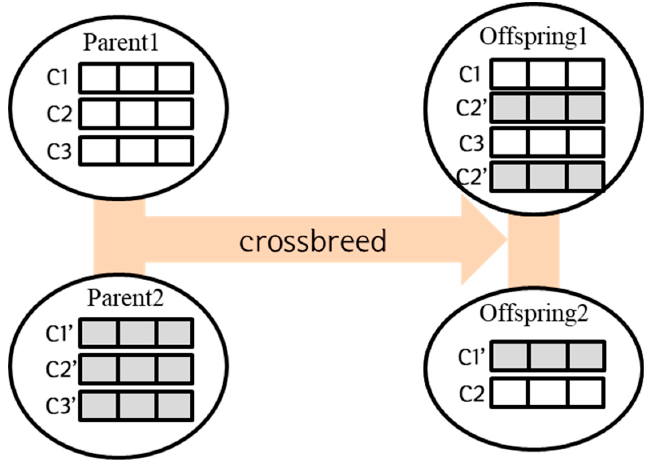
Figure 5. Chromosome attachment.